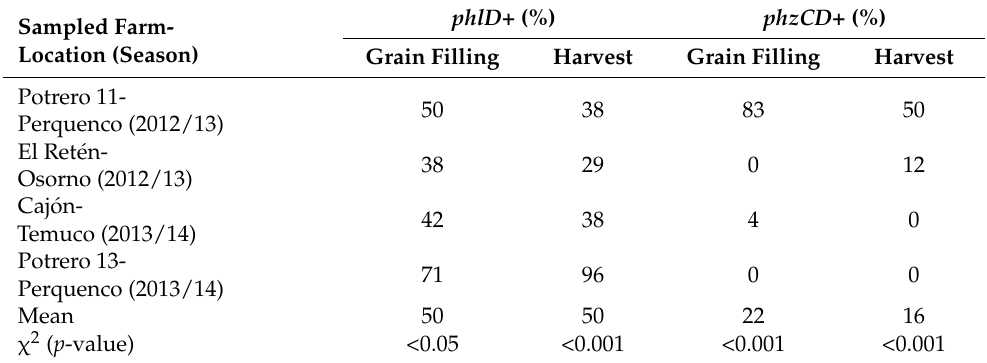
Table 4. Percentage of sampling points 1 (n = 24) positive to bacterial populations with the genes phlD and phzCD determined through PCR from the rhizosphere of 20 wheat culms per sampling point obtained in four intensively sampled fields in southern Chile during the grain-filling and harvesting